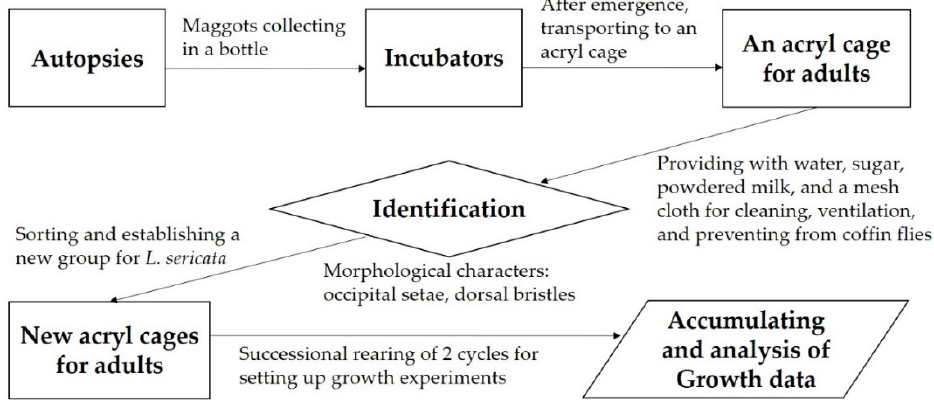
Figure 1. A diagram showing the preparation process for the growth experiment of Lucilia sericata.